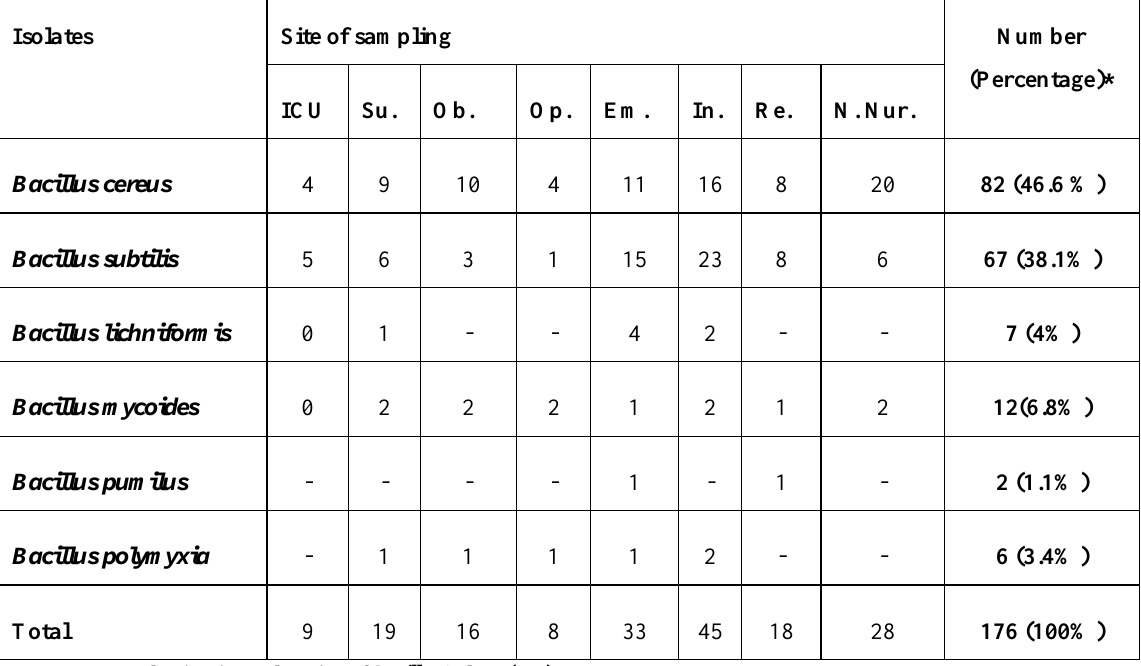
Table 1. Frequency of Bacillus isolates regarding site of sampling.